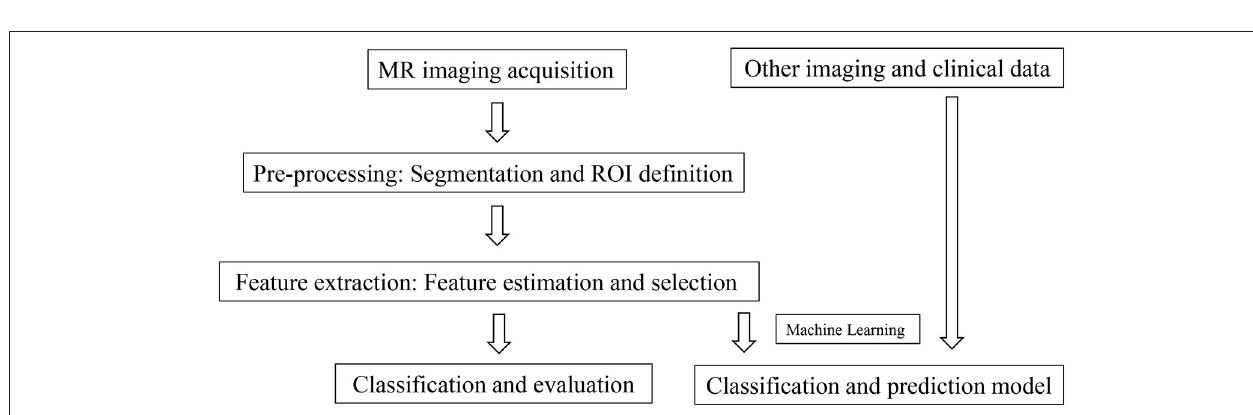
the expected result indicators in a dataset for